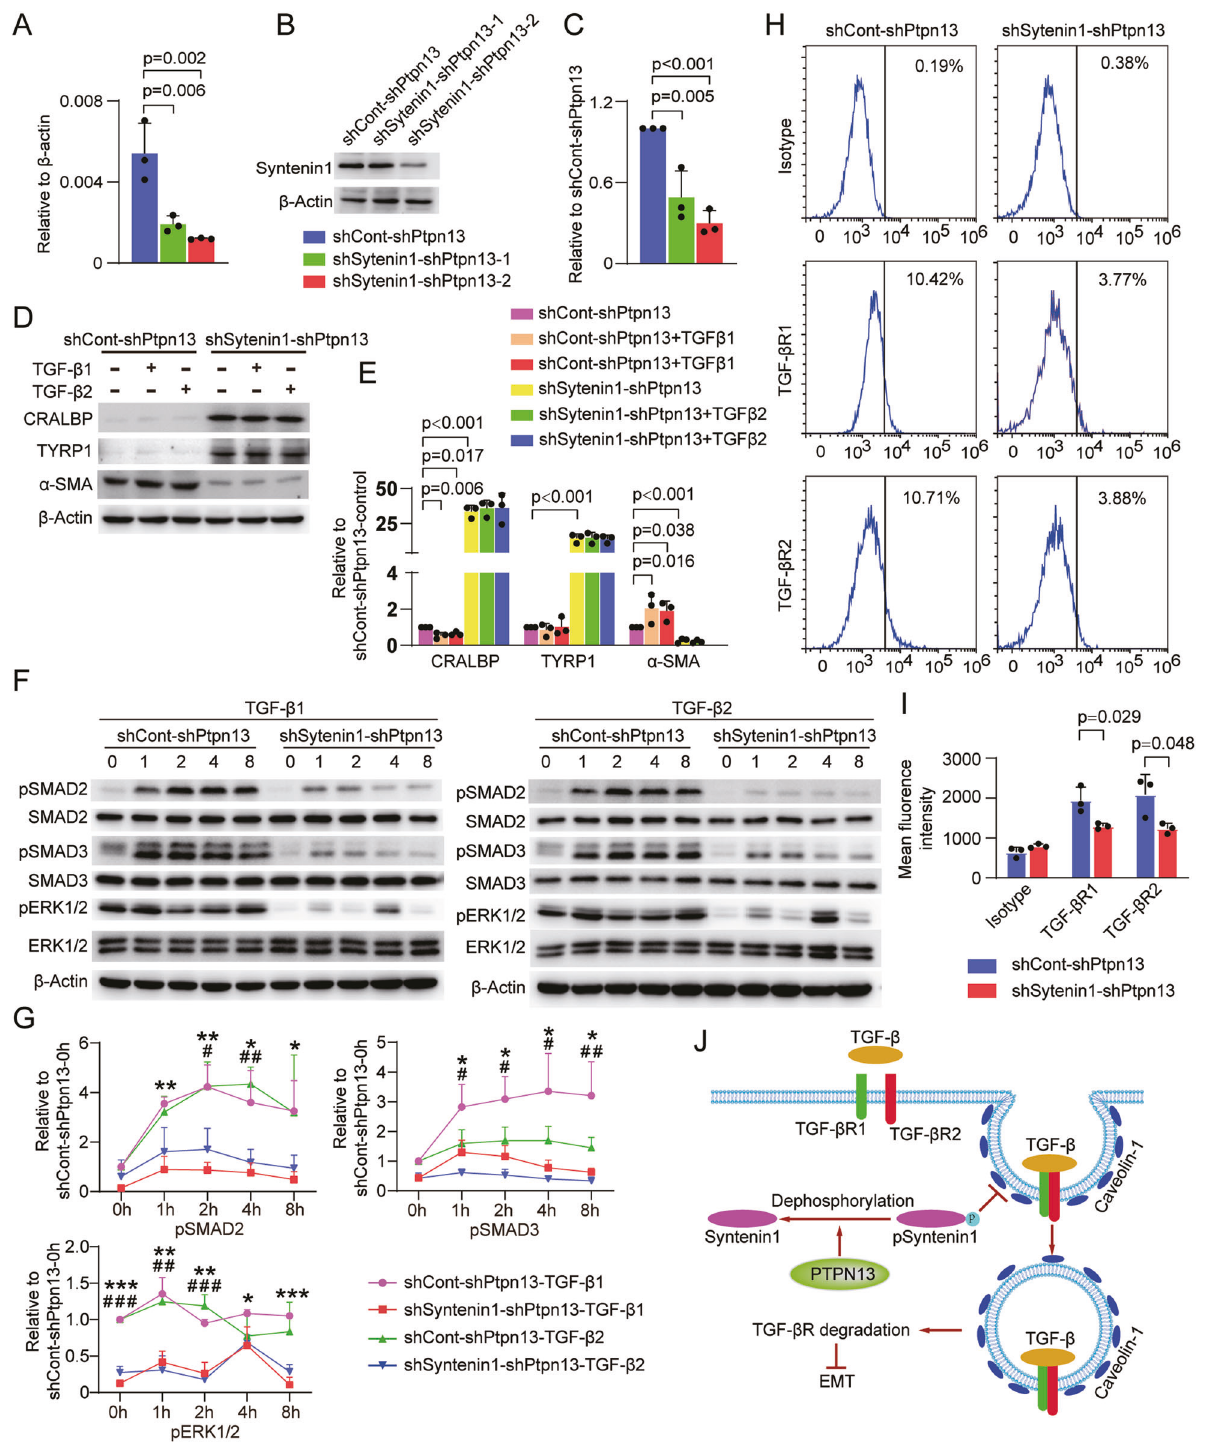
Fig. 6 Syntenin1 mediates the internalization of TGF- β R1 and TGF- β R2. Knockdown ef fi ciency of syntenin1 was determined by A qRT-PCR ( n = 3, P value measured by one-way ANOVA and post hoc Bonferroni ’ s test), B Western blotting, and C quantitative analysis ( n = 3, P value measured by one-way ANOVA and post hoc Bonferroni ’ s test). RPE-speci fi c and EMT-associated markers in shCont-shPtpn13-iRPE and shSyntenin1-shPtpn13-iRPE cells were analyzed by D Western blotting and E quantitative analysis ( n = 3, P value measured by one-way ANOVA and post hoc Bonferroni ’ s test). Phosphorylation of SMAD2/3, p38, and ERK1/2 in shCont-shPtpn13-iRPE and shSyntenin1-shPtpn13- iRPE cells were analyzed by F Western blotting and G quantitative analysis ( n = 3, P value measured by one-way ANOVA and post hoc Bonferroni ’ s test). The expression levels of TGF- β R1 and TGF- β R2 on the cell membranes of shCont-shPtpn13-iRPE and shSyntenin1-shPtpn13- iRPE cells were detected by H fl ow cytometry and I quantitative analysis of mean fl uorescence density ( n = 3, P value measured by Student ’ s unpaired t test). J Schematic model for the PTPN13 dephosphorylating syntenin1 mediates TGF- β receptor internalization and degradation. Results are expressed as mean ± SD. * P < 0.05, ** P < 0.01, *** P < 0.001, shCont-shPtpn13-TGF- β 1 compared with shSyntenin1-shPtpn13-TGF- β 1; # P < 0.01, ## P < 0.01, ### P < 0.001, shCont-shPtpn13-TGF - β 2 compared with shSyntenin1-shPtpn13-TGF- β